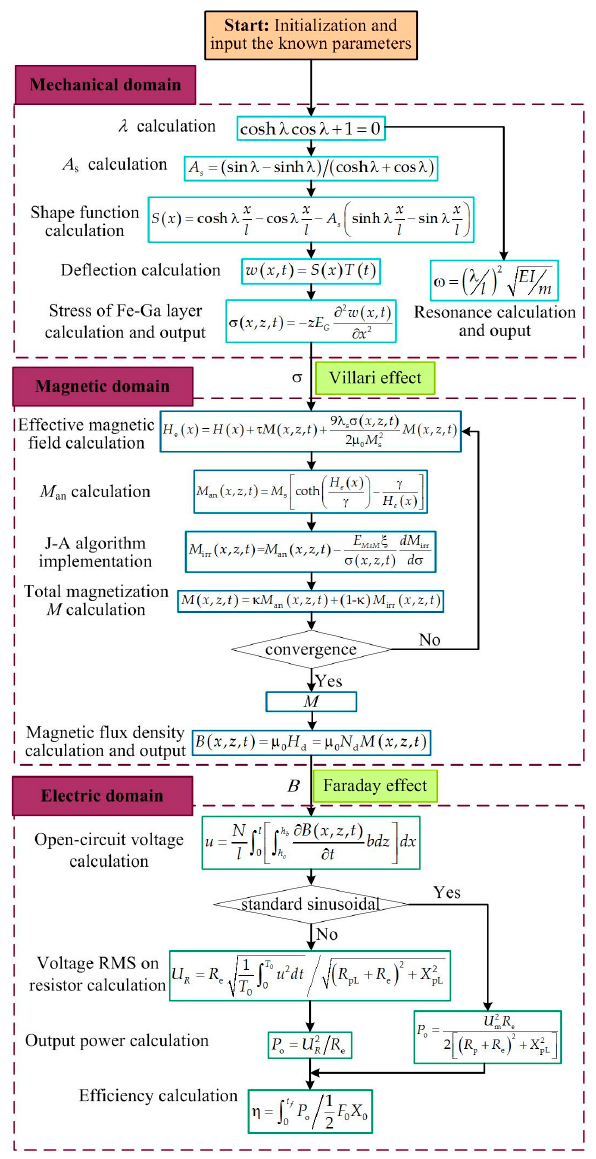
Figure 3. Model algorithm of the Fe-Ga energy harvester.